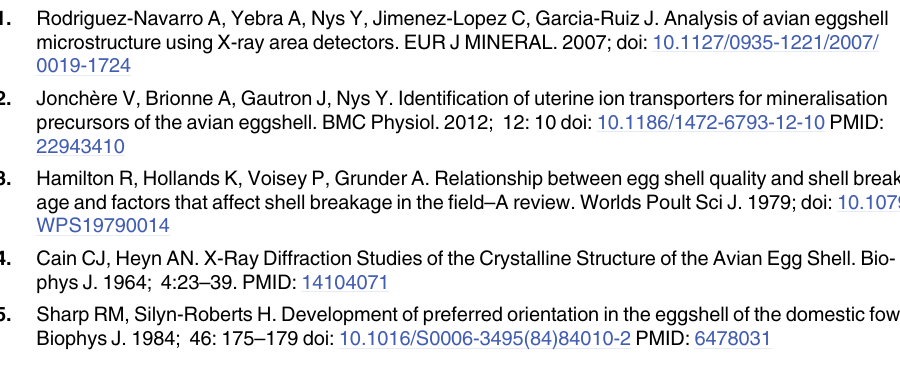
S1 Fig. Linkage disequilibrium analysis for SNPs in 6 ion transport genes respectively. (TIF) S1 Table. The 99 pairs of primers used in this study. S2 Table. The location of the ion transport genes and the distribution of selected SNPs in each of them. a No. of SNP = the number of the SNP selected in each gene (DOCX) S3 Table. The detail information of SNPs and their MAF and call rates in the experiment population. a MAF = Minor Allele Frequency. S4 Table. Effect of the diplotypes on eggshell mechanical property traits. a LSM = least squares means. The values with different letters means significant difference (p value < 0.05); b SE = standard